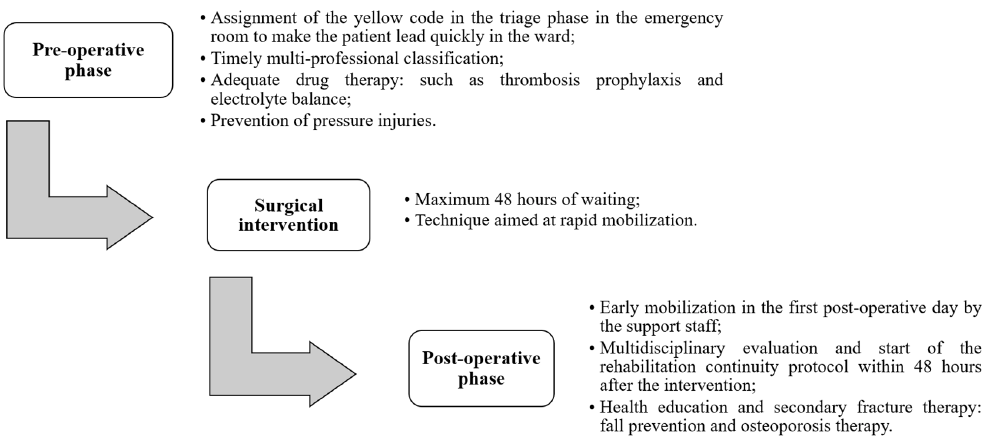
Figure 3. The three main phases of the implemented DTAP.